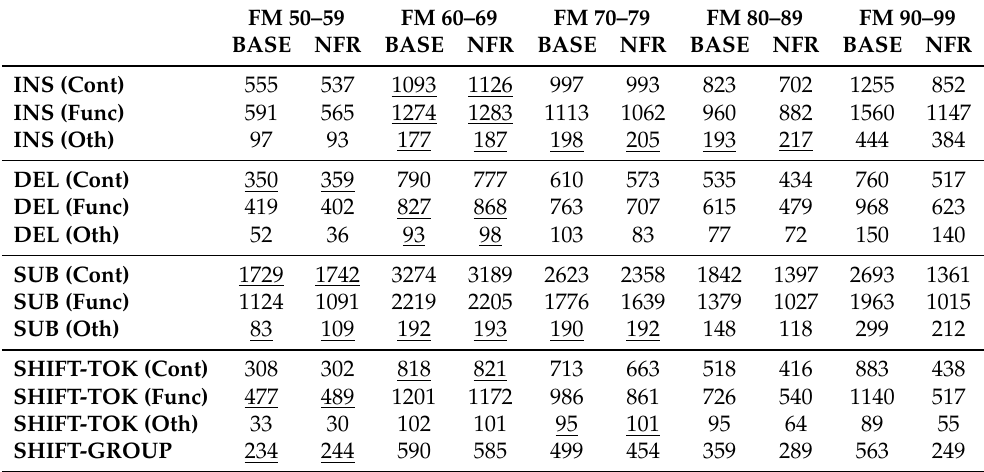
Table A4. Number of TER edits per edit type, for content-words (Cont), function-words (Func) and other tokens/words that did not fall into either category (Oth). Values with a higher amount of edits for the NFR system are highlighted with underscore. BASE refers to the baseline NMT